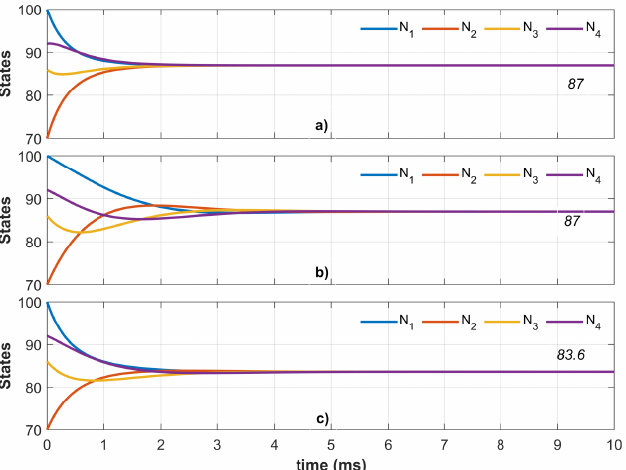
Figure 9. Convergence of the system for the different graph topologies applying the leaderless con- sensus protocol in discrete-time. ( a ) undirected graph; ( b ) directed and balanced graph; ( c ) directed and